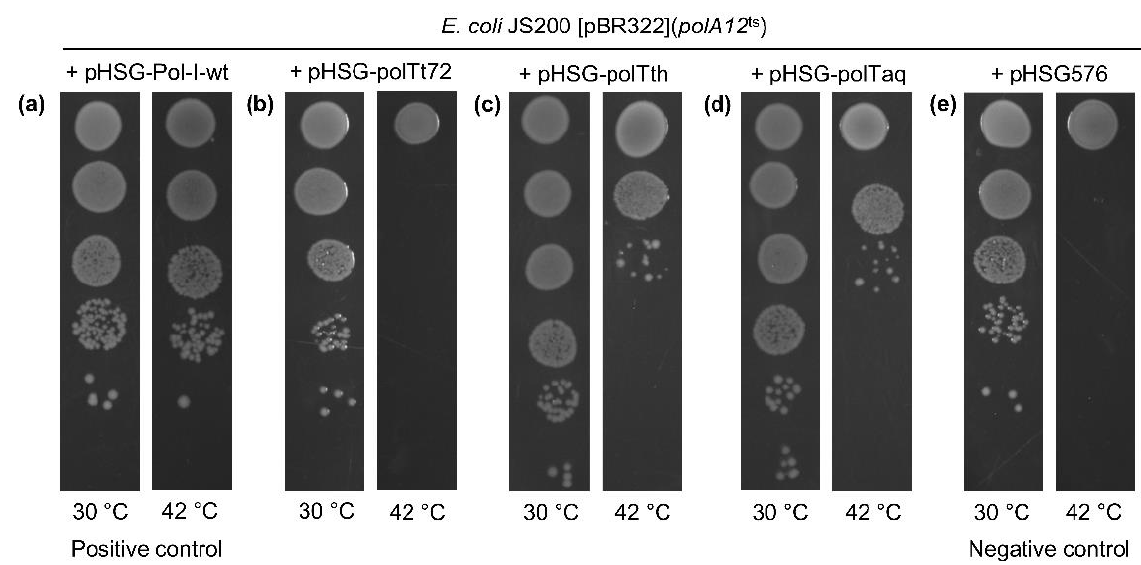
Figure 2. Functional complementation of E. coli polA12 ts by ( a ) wild-type E. coli pol I (positive control), ( b ) Tt72 pol, ( c ) T. thermophilus MAT72 pol I, ( d ) T. aquaticus pol I, and ( e ) vector pHSG576 (negative control). E. coli polA12 ts JS200 [pBR322] was transformed with pHSG-Pol-I-wt (Eco pol I), pHSG-polTt72 (Tt72 pol), pHSG-polTth (Tth pol), pHSG-polTaq (Taq pol), and plasmid pHSG576 (low-copy plasmid with a pol I-independent pSC101 origin replication). Transformed cells were grown to A600 of 0.5 in LB medium containing tetracycline (15 µg/mL), chloramphenicol (34 µg/mL), and ampicillin (100 µg/mL). Then, the cells were serially 10-fold diluted with LB medium, and 5 µL of each dilution was spotted on LA plates supplemented with the same antibiotics and IPTG at a concentration of 1 mM. Plates in duplicate were incubated at 30 °C and 42 °C for 24 – 30 h.